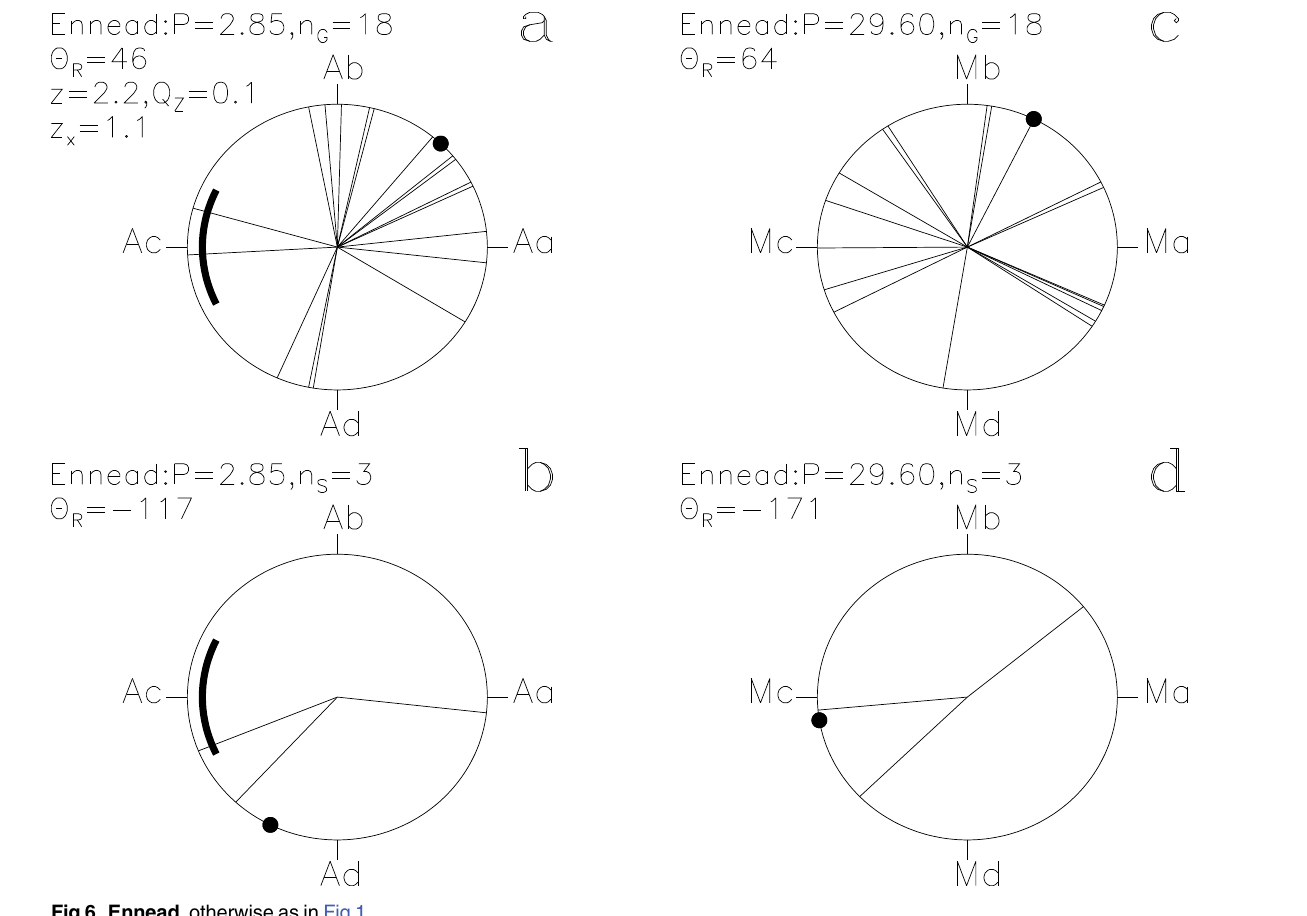
Fig 6. Ennead. otherwise as in Fig